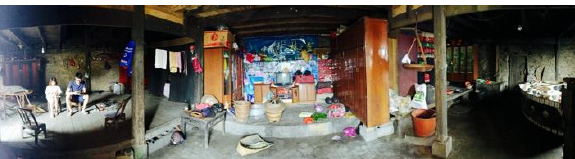
Figure 14. Internal Functional Layout.